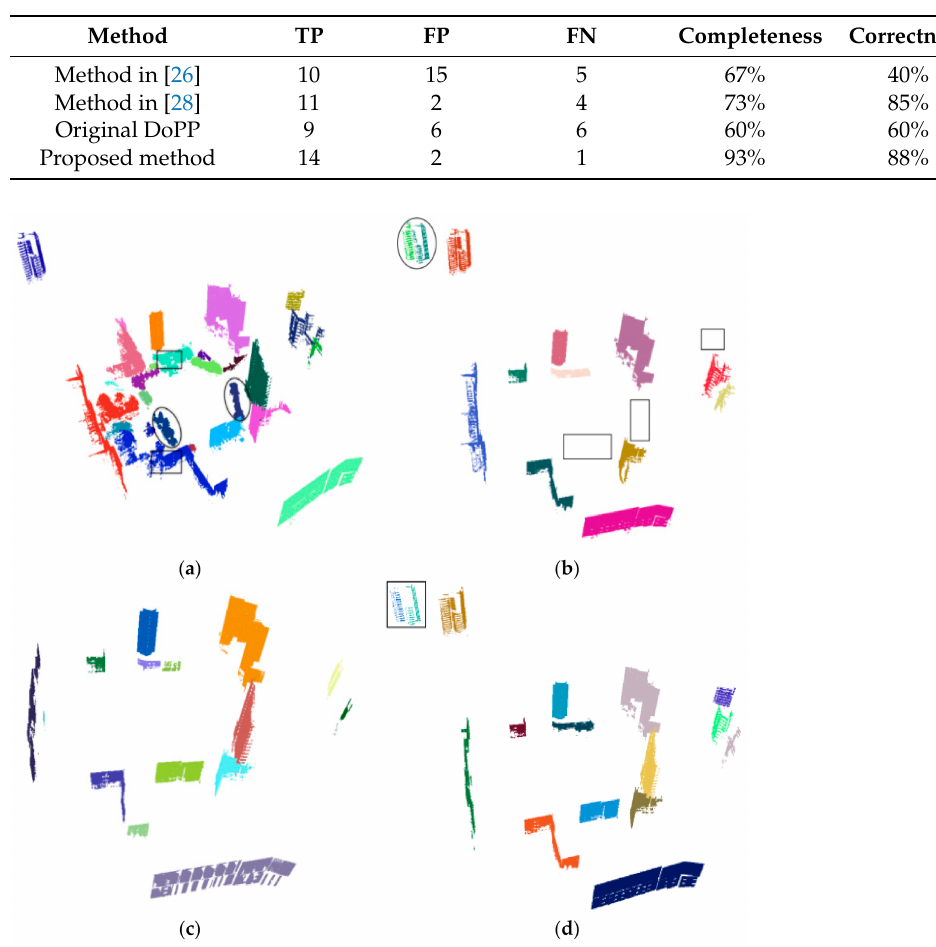
Table 3. Building-based evaluation and comparison between different grid-based methods.